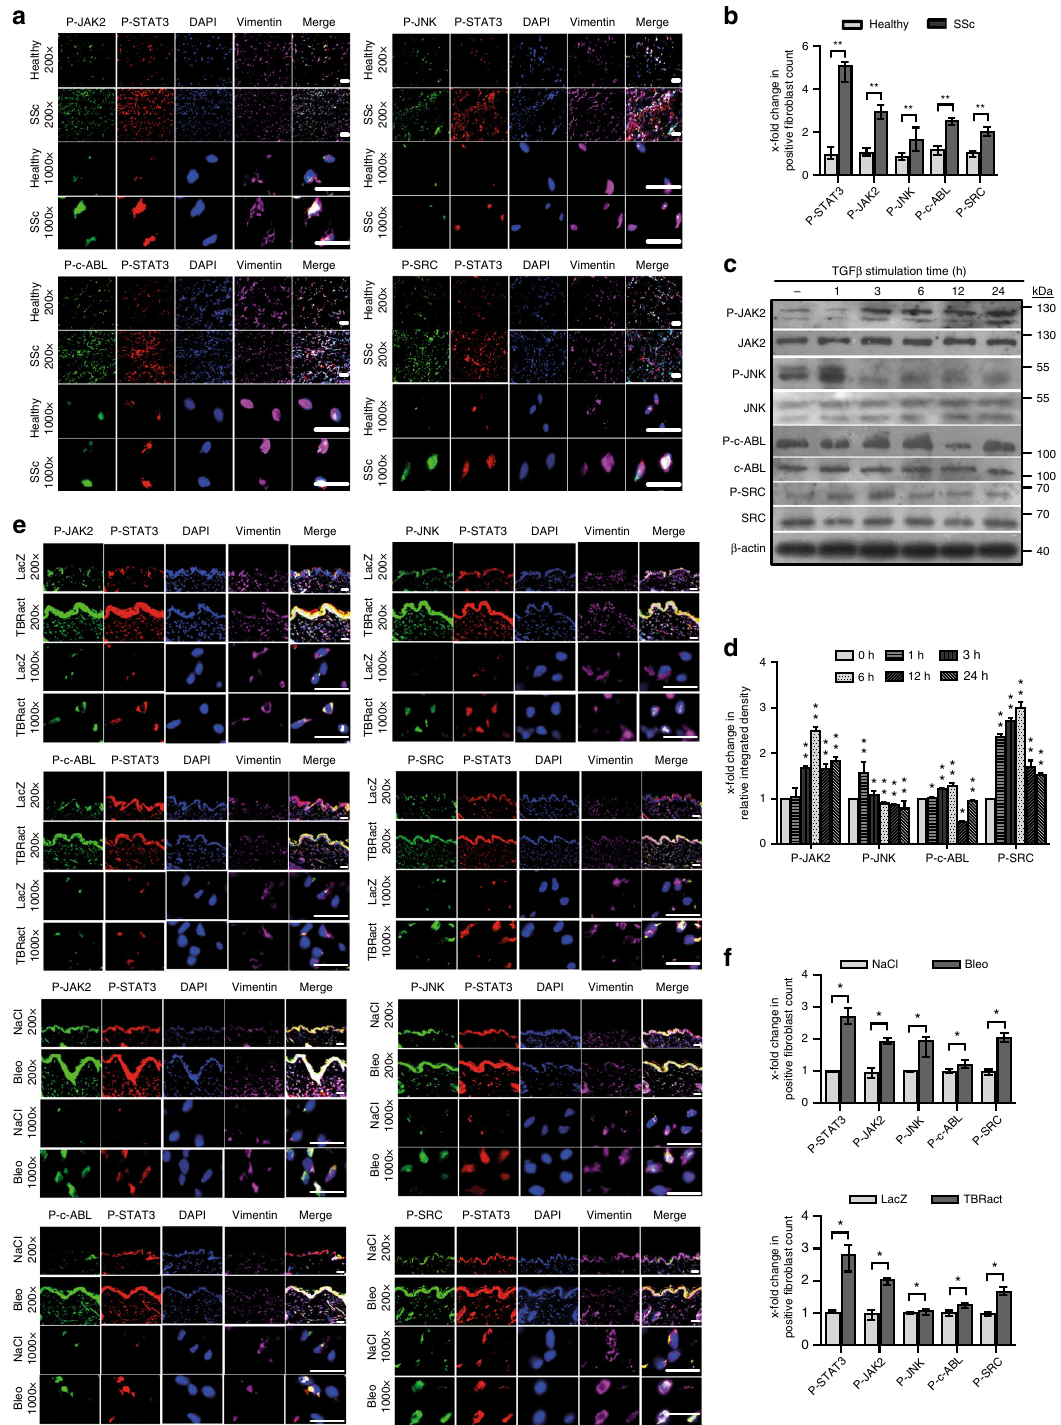
Fig. 3 Activation of JAK2, JNK, SRC, and c-ABL in SSc. a , b Representative images ( a ) and quanti fi cation ( b ) of immuno fl uorescence stainings for P-SRC, P-JAK2, P-JNK, or P-c-ABL co-stained with P-STAT3, DAPI, and vimentin in skin sections of healthy individuals and SSc patients ( n ≥ 4 with 3 technical replicates per group for all experiments). c Western blots and d quanti fi cation of the activation of SRC, JAK2, JNK, and c-ABL in human dermal fi broblasts stimulated with TGF β for different time periods ( n ≥ 4 and 2 technical replicates for all). A representative western blot and quanti fi cation of four independent experiments are shown. e Representative images and f quanti fi cation of immuno fl uorescence stainings for P-SRC, P-JNK, P- JAK2, and P-c-ABL along with P-STAT3 in the skin of mice challenged with bleomycin or overexpressing TBRact with respective non- fi brotic control mice ( n ≥ 4 mice with 3 technical replicates per group for all experiments). Magni fi cations of 200-fold and 1000-fold are shown for all immuno fl uorescence stainings (horizontal scale bar, 100 μ m). JAK2 (expected molecular size, 132 kDa), JNK (expected molecular size, 49 and 55 kDa), c-ABL (expected molecular size, 125 – 135 kDa), and SRC (expected molecular size, 60 kDa) are represented by ladders showing 130, 55, 100, and 70 kDa, respectively. Beta-actin expected molecular weight/size is 42 kDa. Results are shown as median ± interquartile range (IQR). Signi fi cance was determined by Mann – Whitney test, as compared to healthy individuals, unstimulated fi broblasts or with non- fi brotic control mice, respectively.* P < 0.05; ** P <